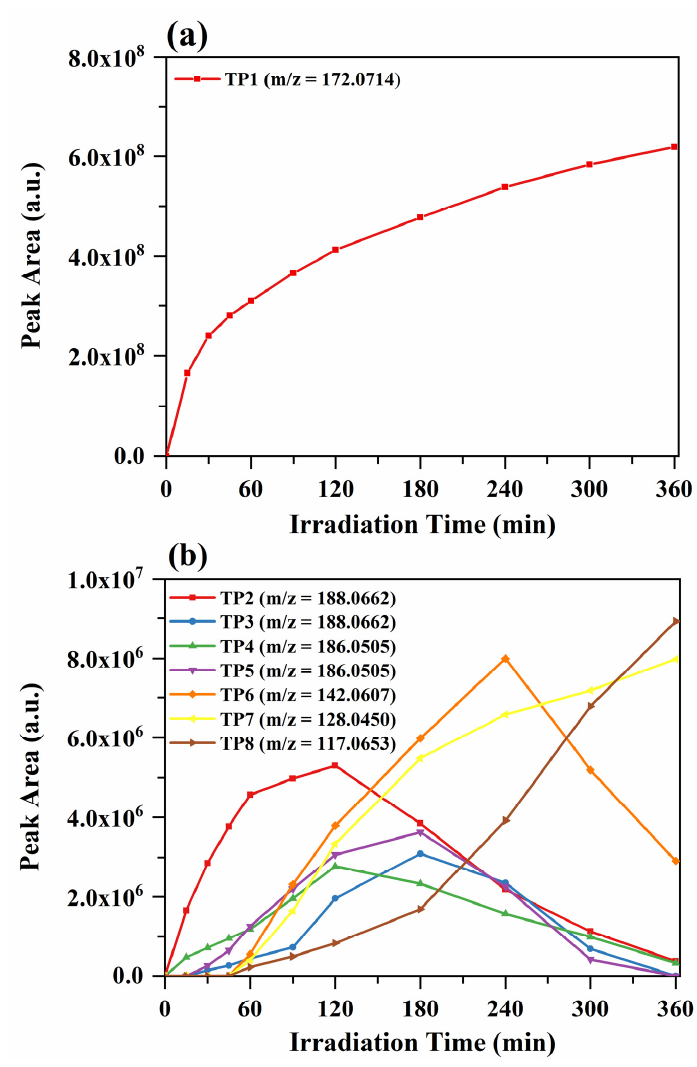
Figure 2. Evolutionary profiles of ( a ) TP1 and ( b ) TP2-8.